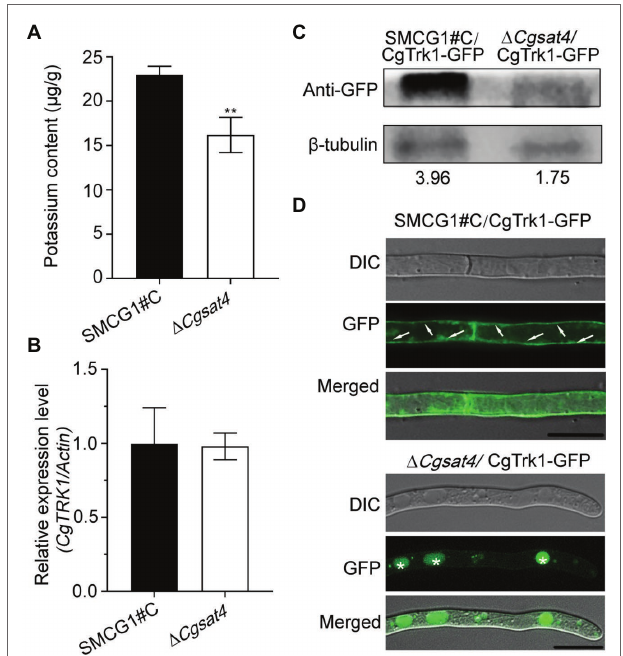
FIGURE 2 | CgSat4 required for potassium uptake and the localization of potassium transporter CgTrk1. (A) Mycelia K + concentration of the WT and ∆ Cgsat4 mutant cultured in CM medium. n = 3. (B) Transcription level analysis of CgTRK1 in the WT and ∆ Cgsat4 mutant using qRT-PCR. (C) Western blotting analysis of CgTrk1 in the WT and ∆ Cgsat4 mutant using an anti-GFP antibody. (D) Localization pattern of the fusion protein CgTrk1-GFP in the WT and ∆ Cgsat4 mutant. The arrows and asterisks represent the plasma membrane and vacuole, respectively. Error bars represent the SD, and asterisks indicate significant difference at p <